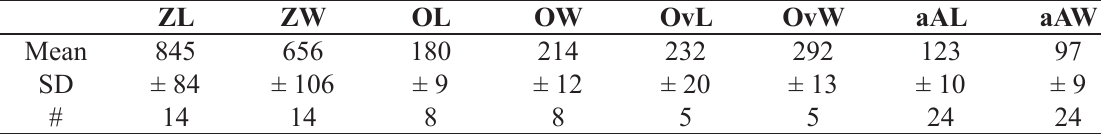
Table 13. Measurements of Calvetopora inflata (Calvet, 1906) gen. et comb.